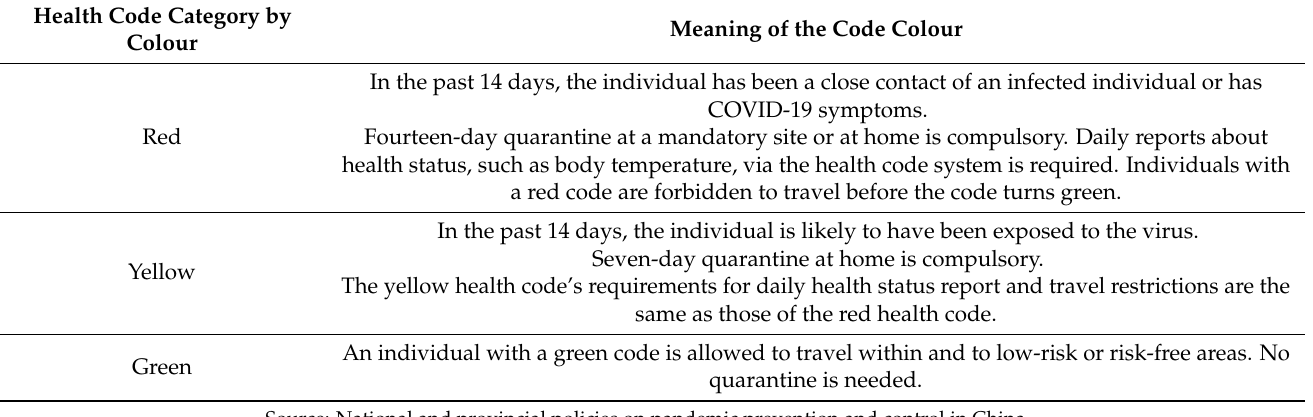
Table 1. Categories and meanings of health codes.